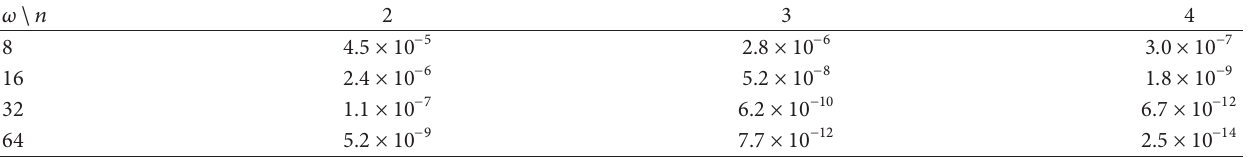
3 (𝑥 − 2) −(1/2) (3 − 𝑥) −(1/2) sin 𝑥𝑒 𝑖𝜔𝑥 𝑑𝑥 , 2